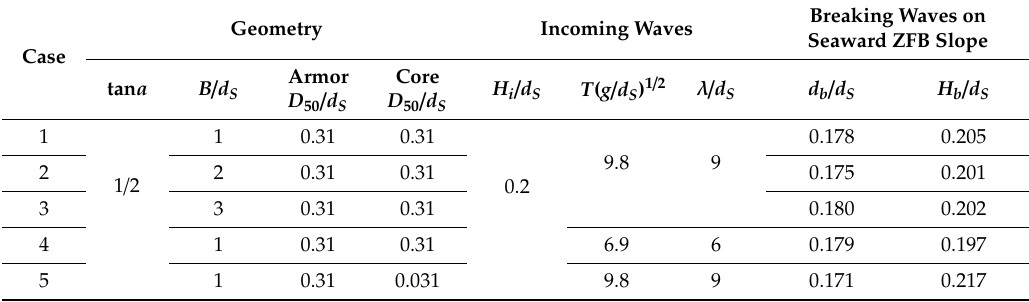
Table 1. Geometrical characteristics of the examined ZFB cases, the parameters of the incoming waves and the breaking ones on the seaward slope of the